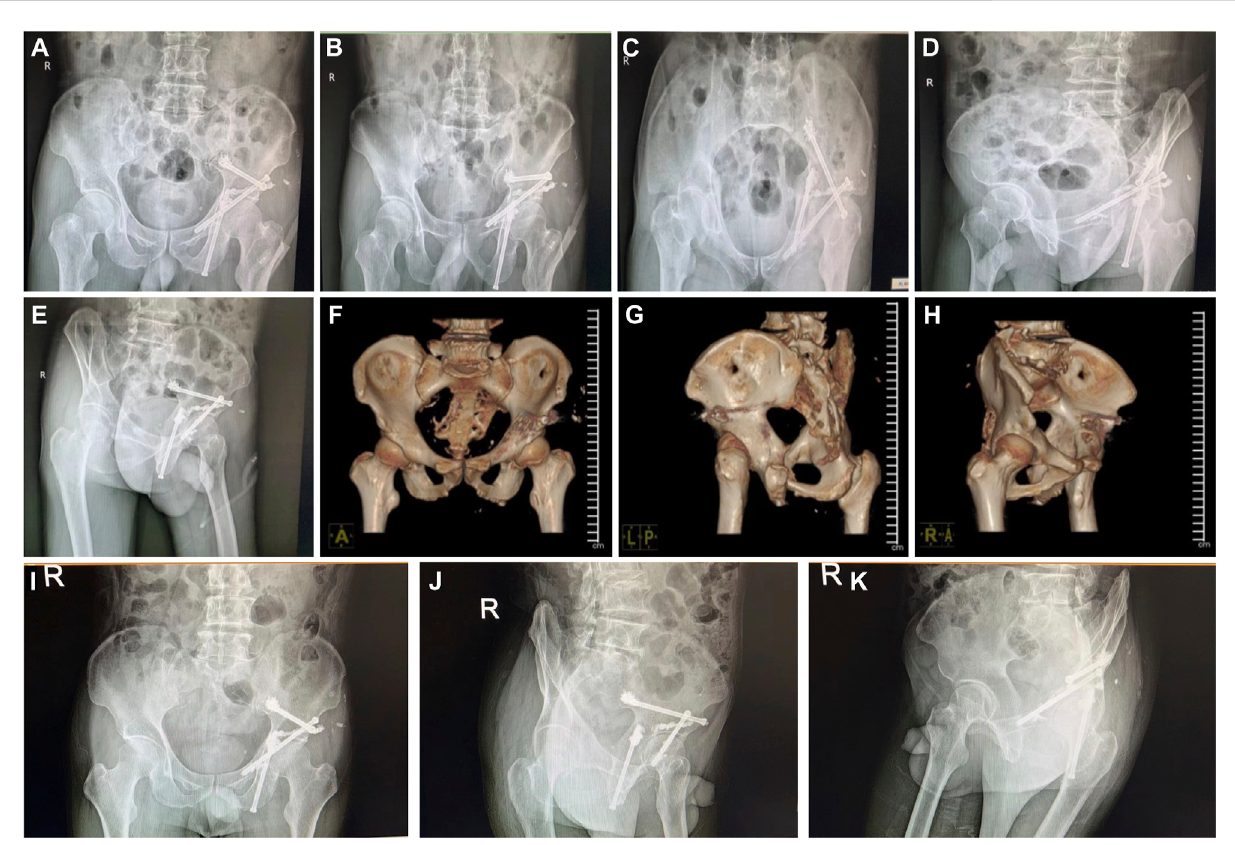
FIGURE 4 Postoperative review of X-ray radiographs and CT 3D reconstruction, and the postoperative follow-up X-ray images of the patient. (A – E) Different anglesofX-rayradiographsonthepelvistoevaluatetheoperation (F – H) CT3Dreconstructionofthepelvistoassesstheoperation. (I – K) Differentangles of X-ray radiographs on the pelvis to evaluate the operative area in the postoperative follow-up